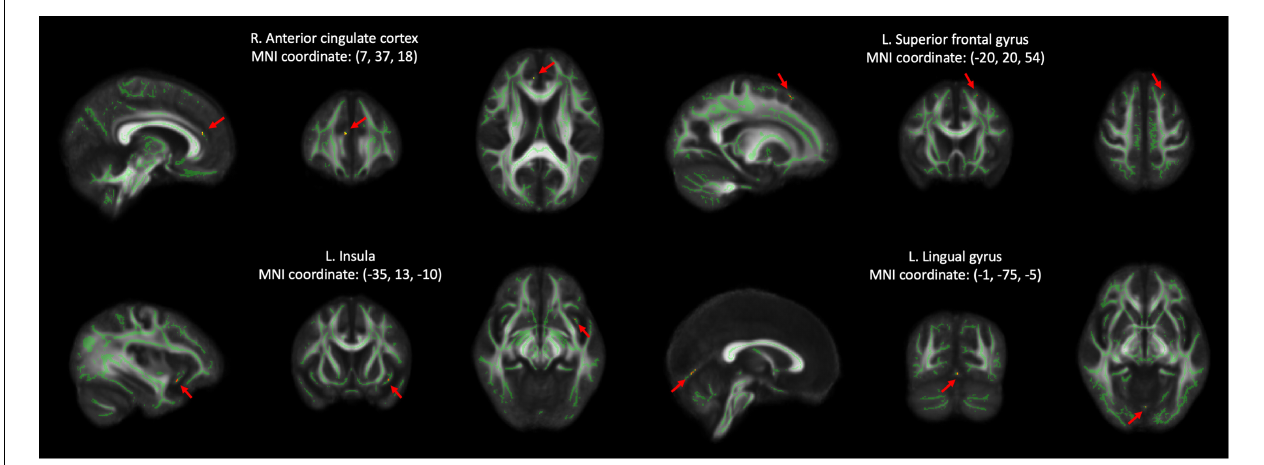
FIGURE 2 | Results of voxel-wise group comparison and TBSS using the TFCE with uncorrected p < 0.001 and cluster size ≥ 4. TBSS, tract-based spatial statistics; TFCE, threshold-free cluster enhancement; L, left; R, right; MNI, Montreal Neurological Institute.